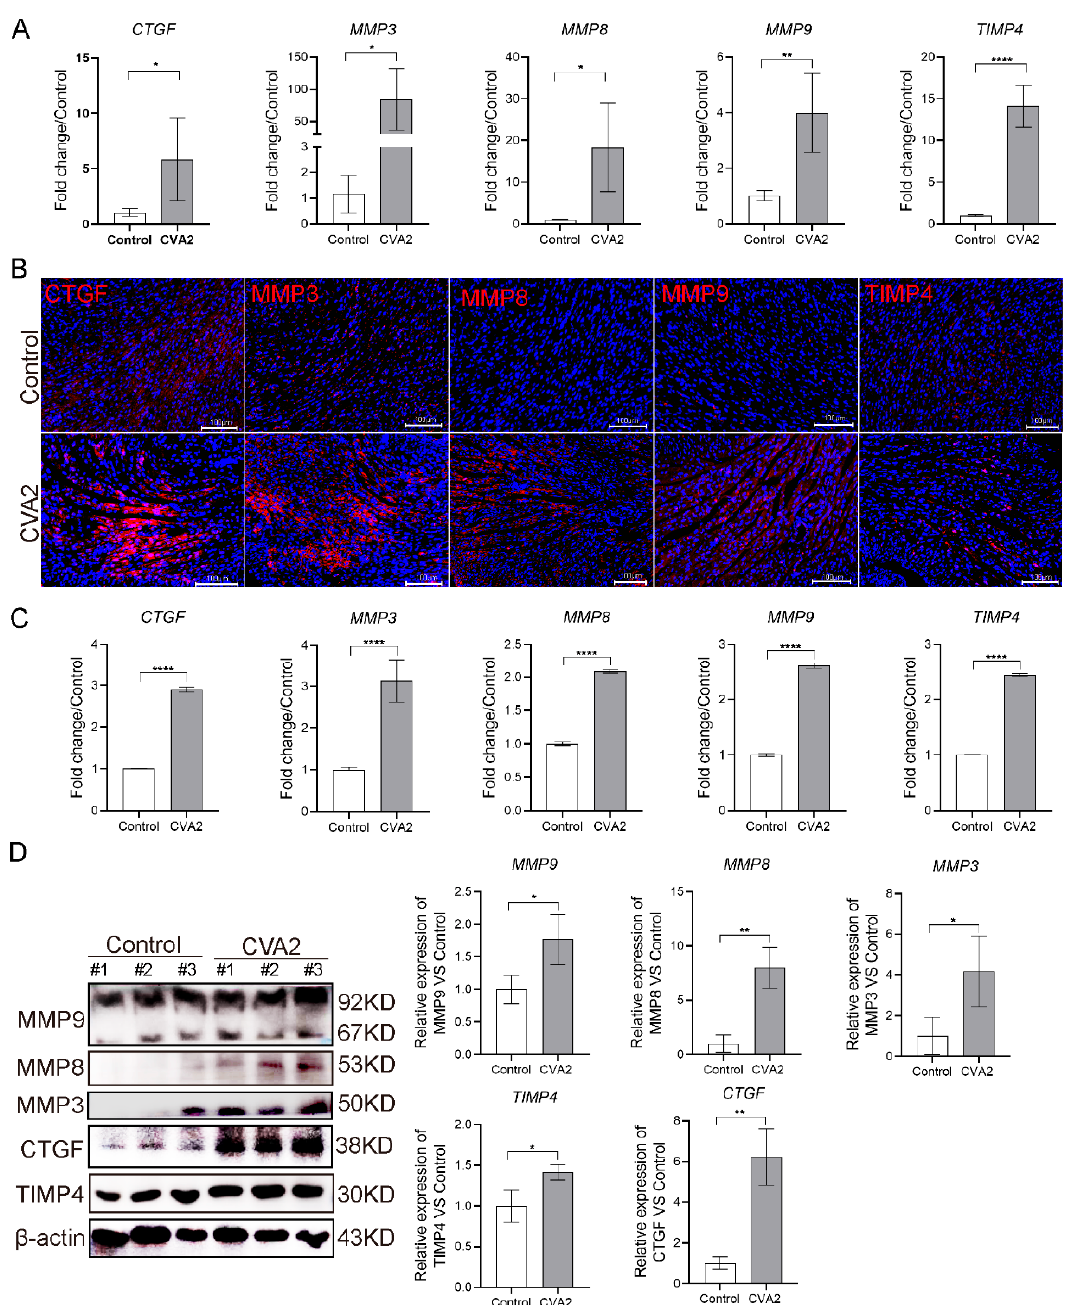
Figure 3. The disruption of cell-matrix interactions in heart tissues after CVA2 infection. ( A ) Relative expressions of CTGF, MMP3, MMP8, MMP9 and TIMP4 mRNA in heart tissues. ( B , D ) Immunofluorescence staining and WB analysis of CTGF, MMP3, MMP8, MMP9 and TIMP4 protein (red) in heart tissues. ( C ) The fluorescence intensity of CTGF, MMP3, MMP8, MMP9 and TIMP4 in mouse hearts ( n = 4 per group). * p < 0.05, ** p < 0. 01, **** p < 0.0001 vs.